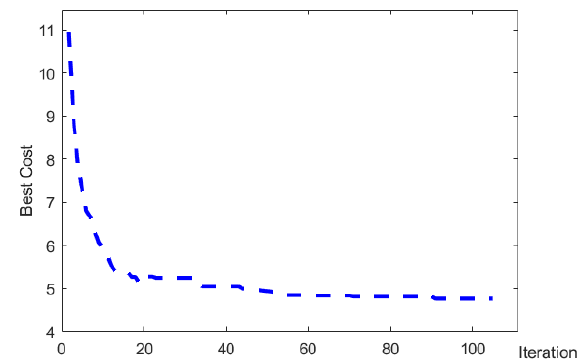
Figure 5: Reducing total energy consumption of the network over 100 iterations using the ANT Colony